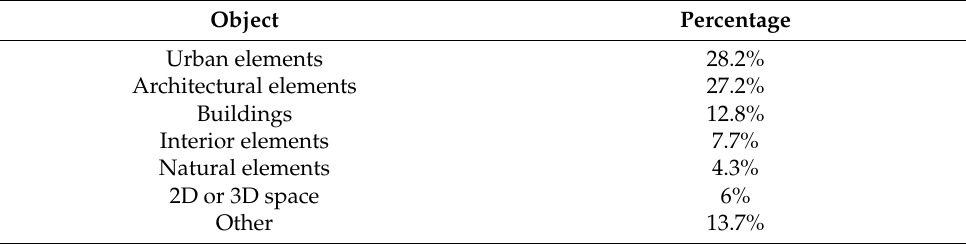
Table 4. Type of real element or object present in the tasks.